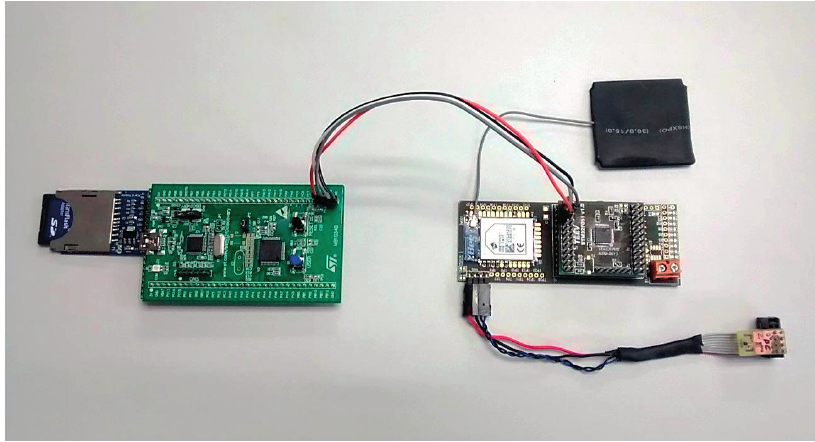
Figure 5. Monitor node connected to sensor